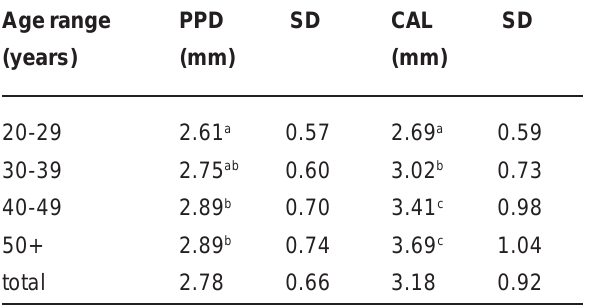
TABLE 2- Number and % of sites at different CAL by age cohort